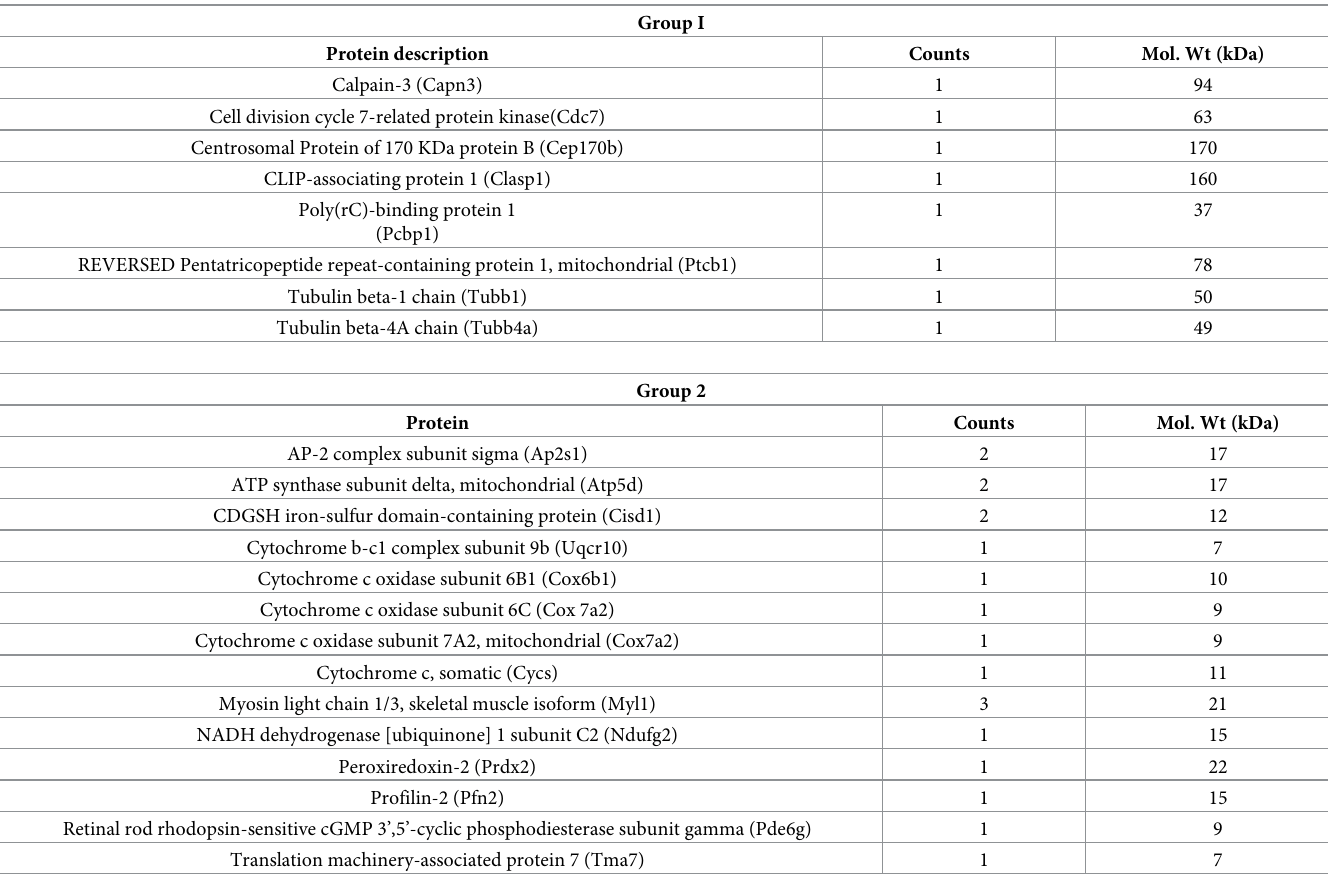
Table 3. Fragments of proteins present only in the insoluble fraction of β A3 cKO lenses relative to WT and HET lenses following centrifugation at 5000